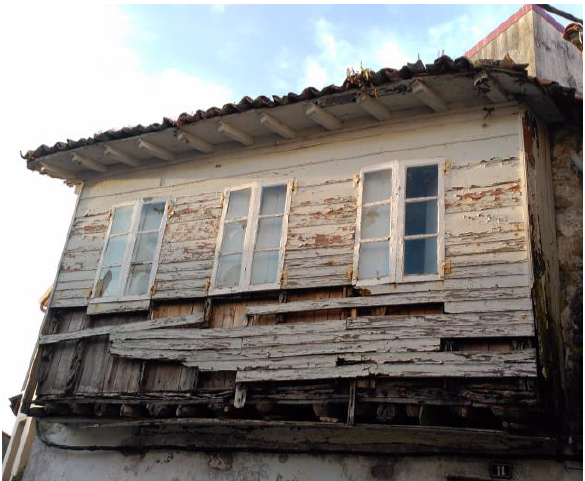
Figure 7. Half-timbered house with plank covering in